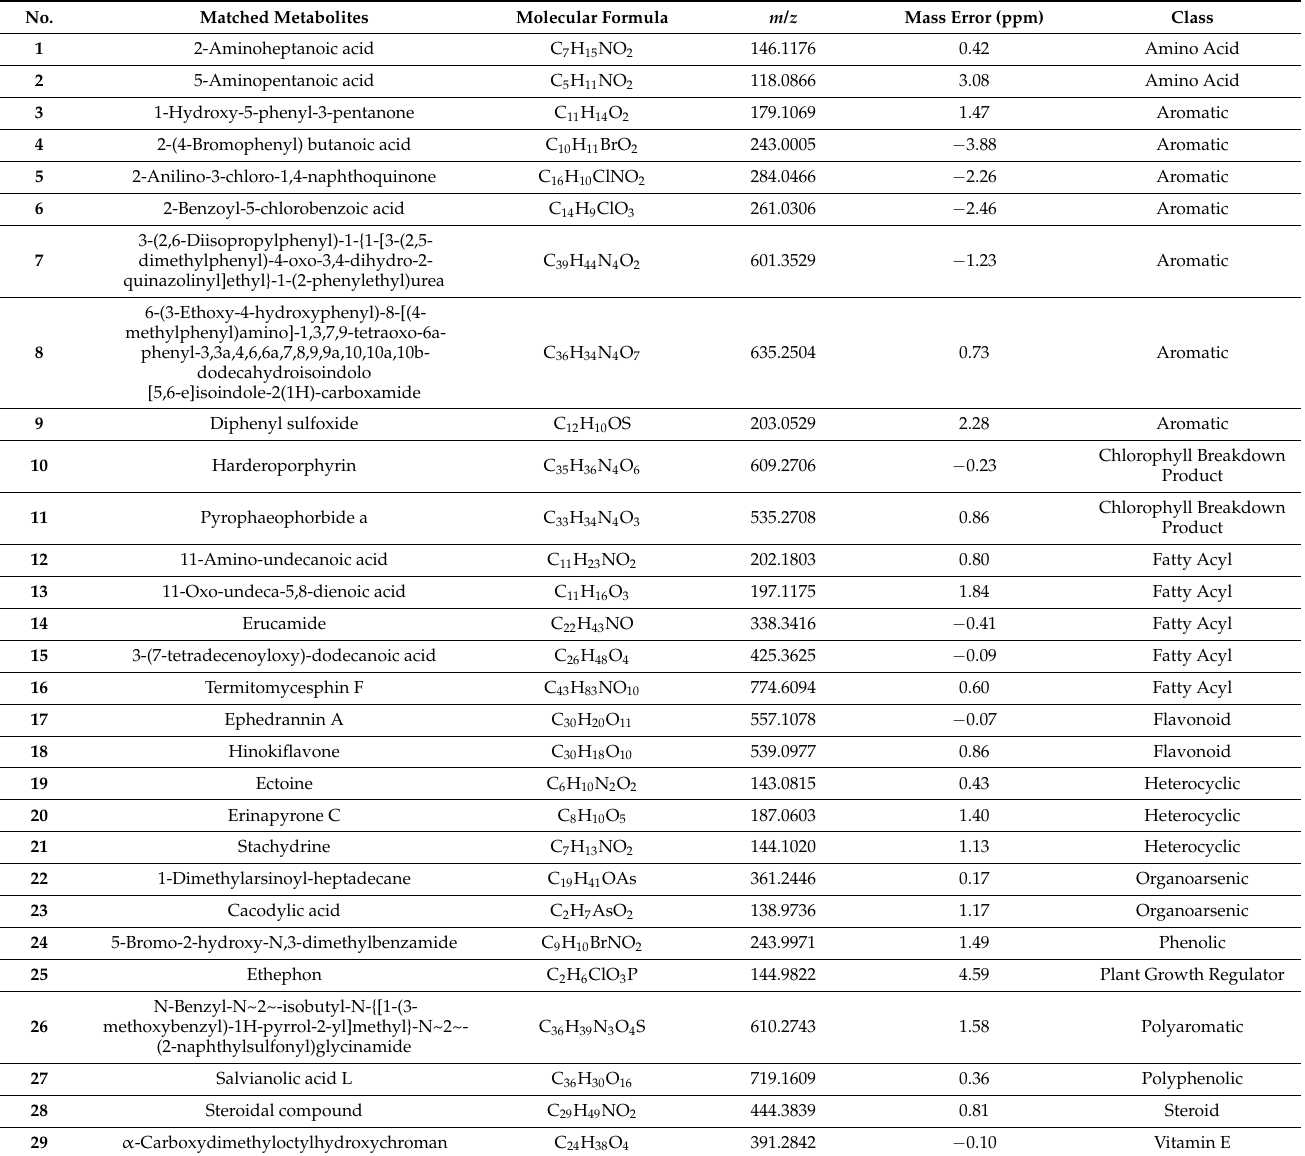
Table 3. Matched metabolites in the methanol extract of Sargassum polycystum